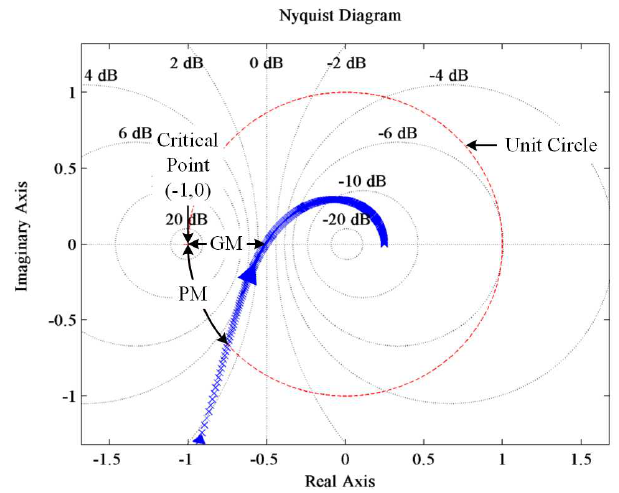
Figure 8. Nyquist diagram of the current control in GC